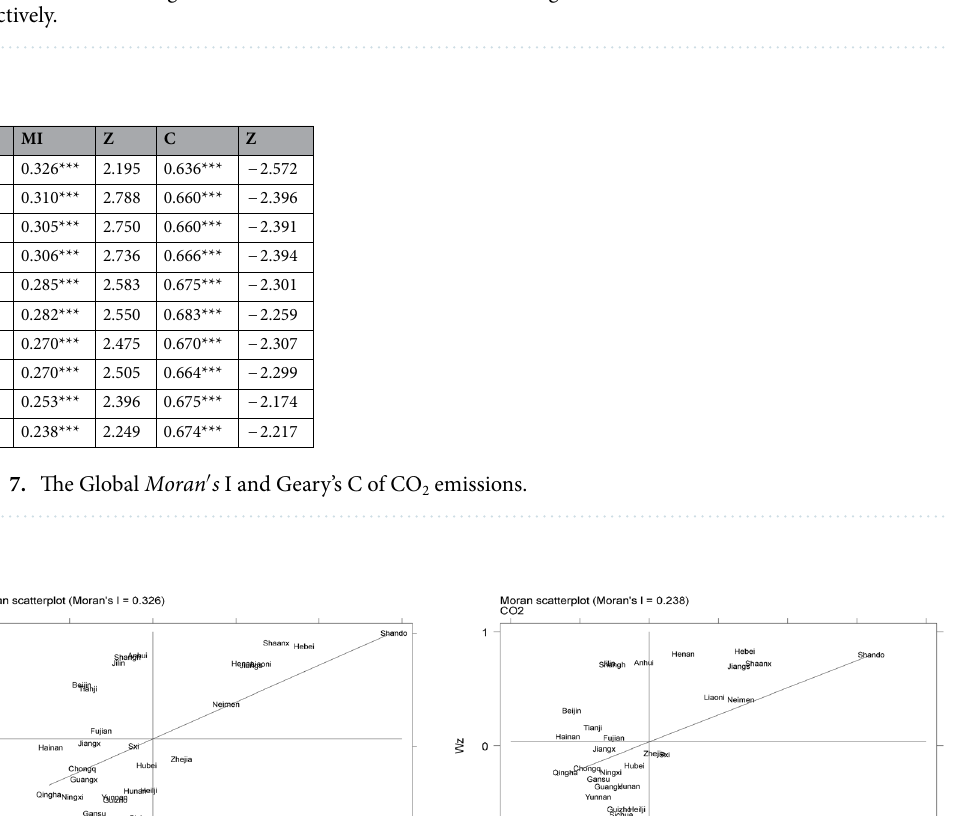
Table 6. Benchmark regression results. ***, **and * indicate the significance at 1%, 5% and 10% levels respectively.